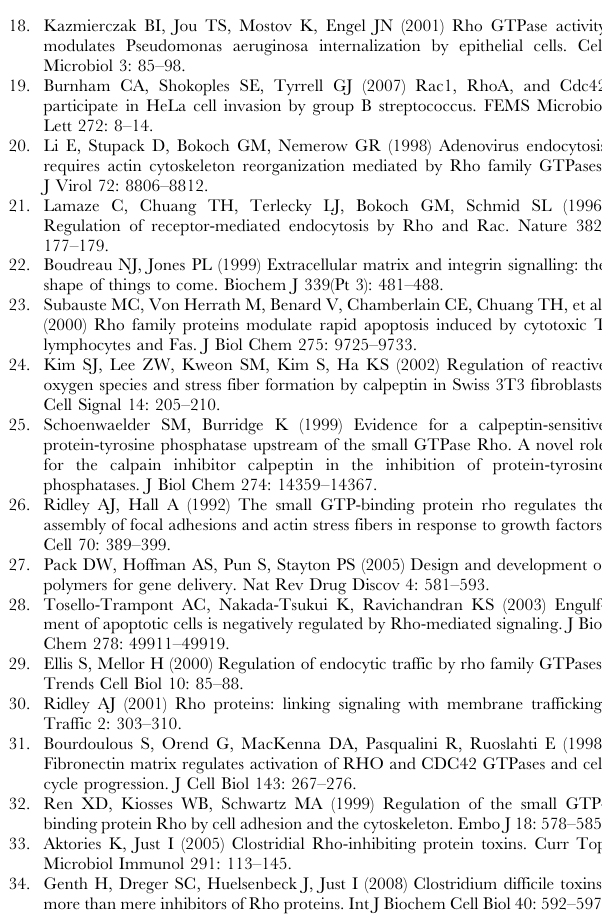
Figure S2 Percent cells transfected with dominant negative and constitutively active genes, and the effect on cell viability. To study the effect of direct inhibition and activation of RhoGTPase on gene transfer in cells plated on fibronectin tissue culture plastic, D1 cells were